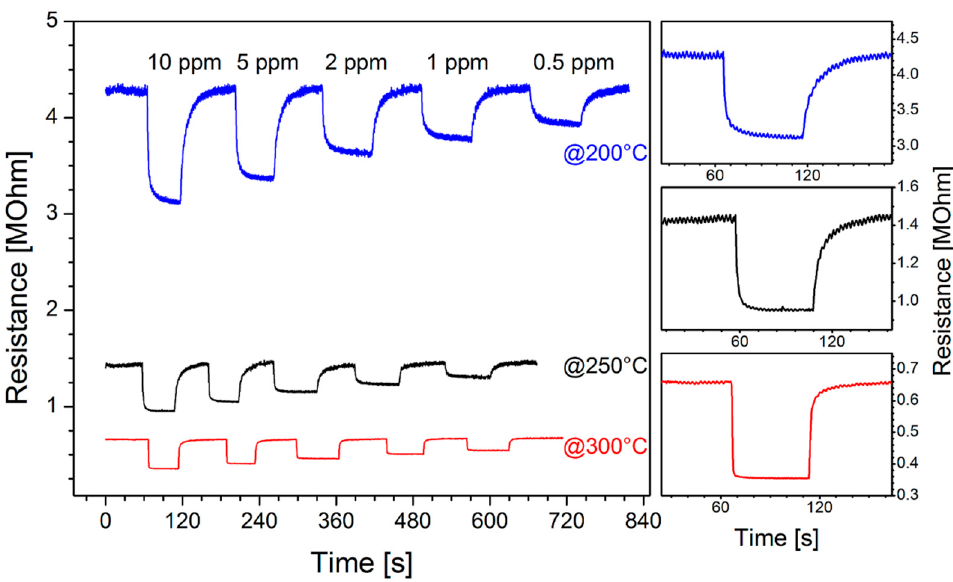
Figure 3. Left : dynamic resistance at different temperature values, during the injection of different concentrations of ammonia. Right : magnification of the response to 10 ppm of ammonia at each working temperature.